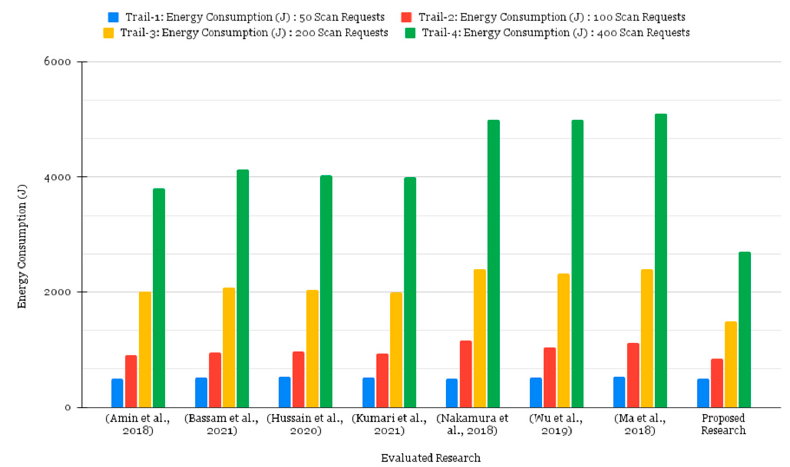
Figure 9. Energy